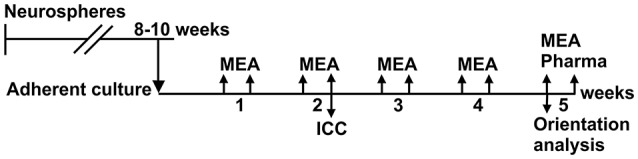
Timeline of the experiments. Neurons were differentiated in neurosphere culture for 8–10 weeks before adherent culture in tunnel devices on MEAs and in standard cell culture wells (control cells). MEA measurements were performed twice weekly over 5 weeks, and a pharmacological test was performed at the end of the culture. Neurite orientation analysis was performed from the phase contrast images taken at the 5th week. Immunocytochemistry was performed on control cells after 2 weeks in adherent culture for both cell lines.